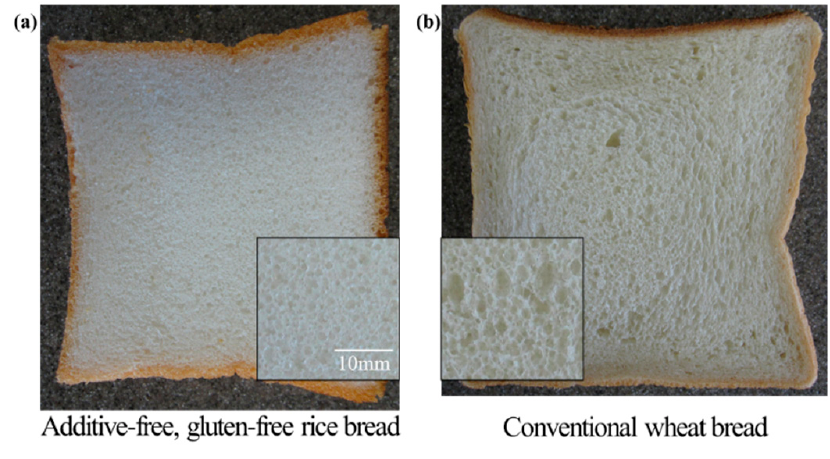
Figure 4. Appearances of additive-free, gluten-free rice bread ( a ) and wheat bread ( b ).